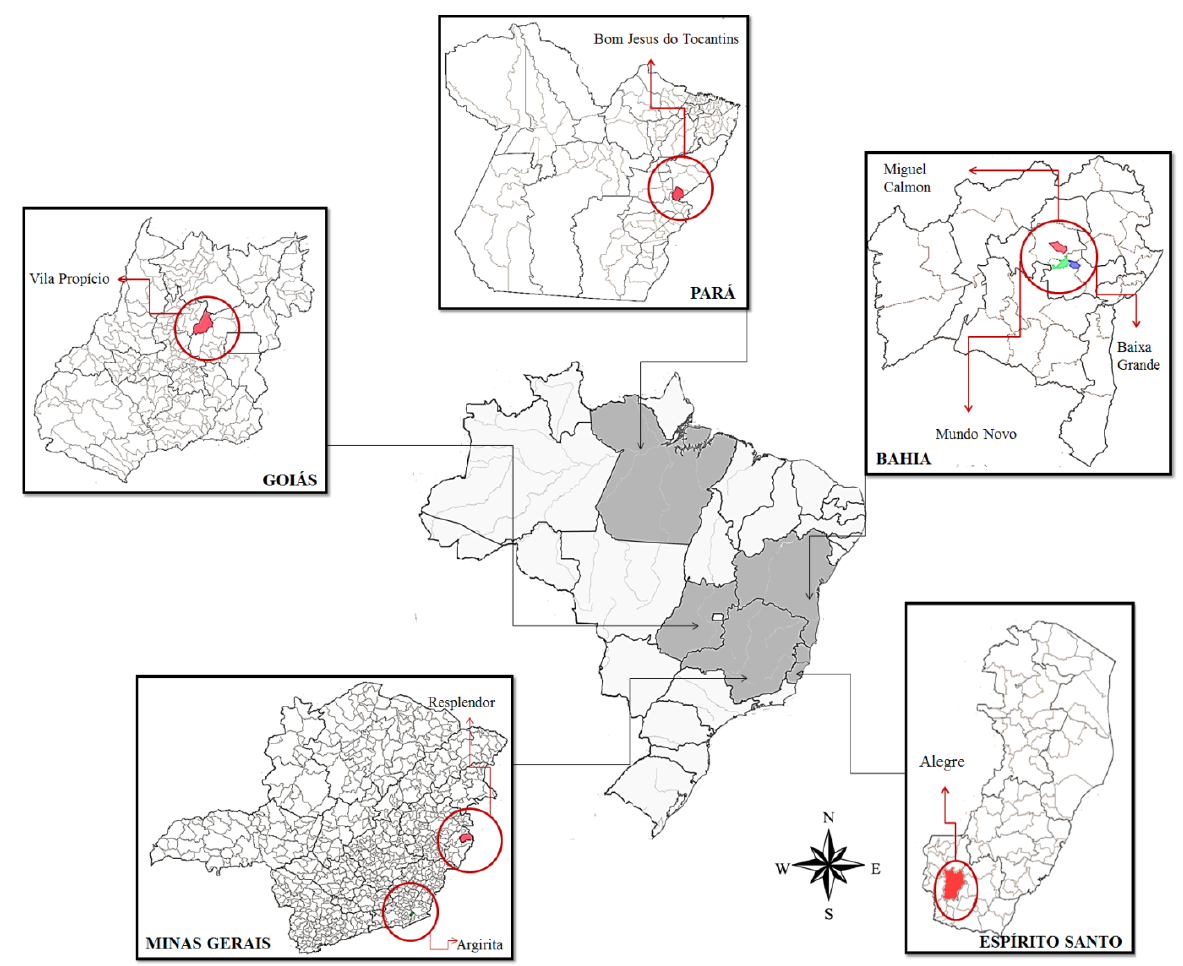
Figure 1. Map displaying Brazilian states and counties from which the clinical samples used for Vaccinia virus clone isolation were collected. The red circles indicate the counties where the samples were collected: Miguel Calmon, Baixa Grande and Mundo Novo counties localized in Bahia state, Vila Propício county localized in Goiás state, Bom Jesus do Tocantins county localized in Pará state, Resplendor and Argirita counties localized in Minas Gerais States and Alegre county in Espírito Santo